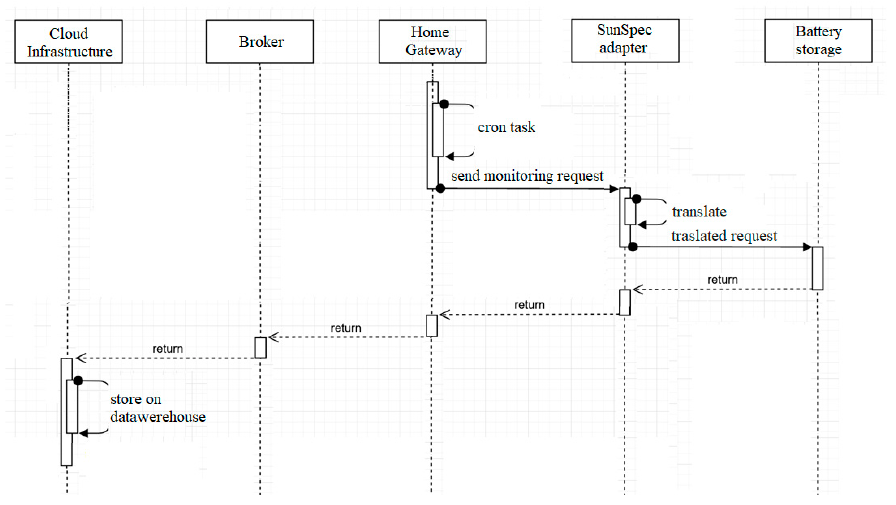
Figure 10. Data flow for sending monitoring requests to the battery storage operation when using the SunSpect adapter.